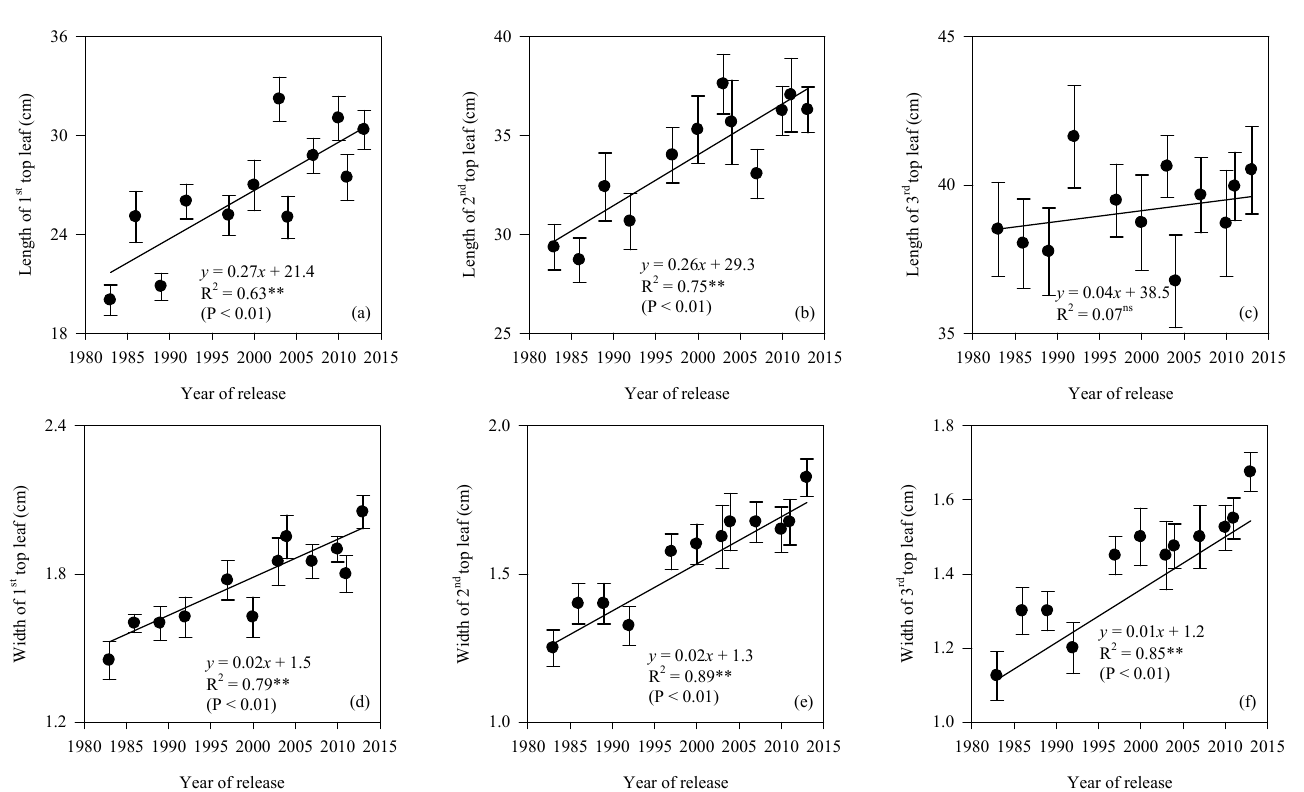
Figure 4. Relationships between year of release and length and width of 1st top leaves ( a , d ), 2nd top leaves ( b , e ), and 3rd top leaves ( c , f ) at 30 DAH of rice cultivars. DAH, days after heading. Data were fitted by linear regression ( y = a x + b). In the linear regression, x was reassigned as years after 1983; for example, x was valued as 1 in 1983 and so on. **, significant at the 0.01 probability level according to the LSD test; ns, not significant at the 0.05 probability level according to the LSD test. Vertical bars represent ± standard error of the mean ( n = 6).